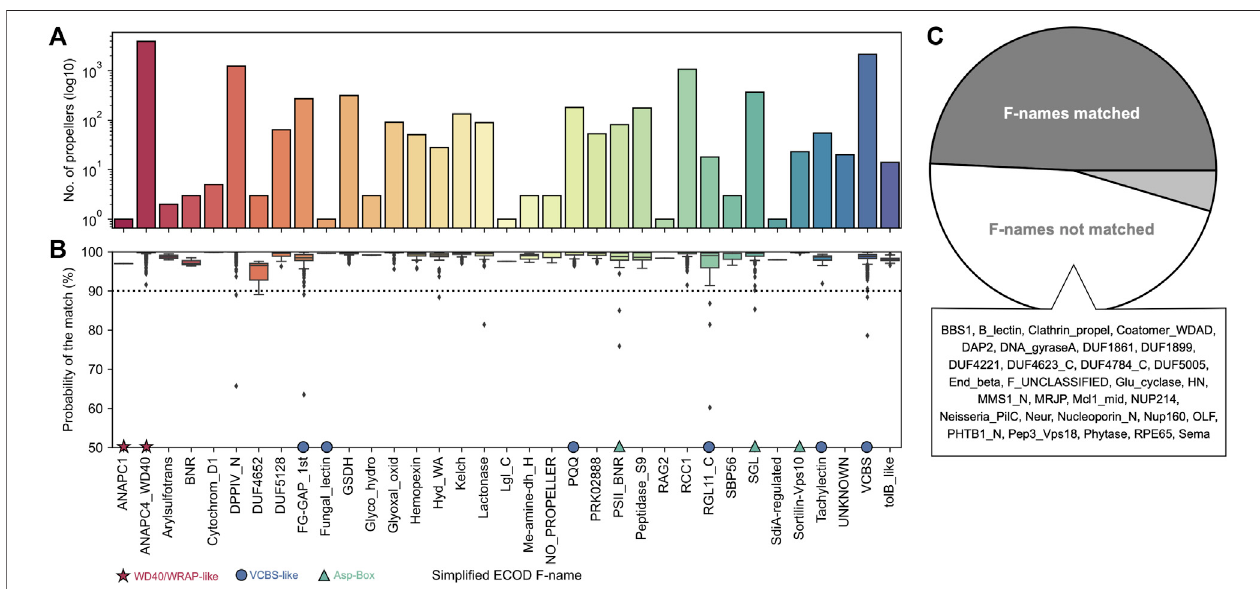
FIGURE1| TheECODfamiliesmatched. (A) Frequency ofthedifferentECODF-names (in theirsimpli fi edform)matched. (B) BoxplotsoftheHHsearchprobability of the match, per family. The most abundant families belonging to one of the three main groups of β -propellers, as described in the text, are marked: stars mark WD40, WRAP-like propellers, circles mark VCBS and VCBS-like (including PQQ) propellers, and triangles the three main families making the Asp-Box group. (C) Proportion of ECODF-namesmapped,withalistofthosewithoutany matchto β -propeller-likesequences inourdataset.TheUNKNOWNfamilycorrespondstothesequences without signi fi cant matches to any of the 65 ECOD